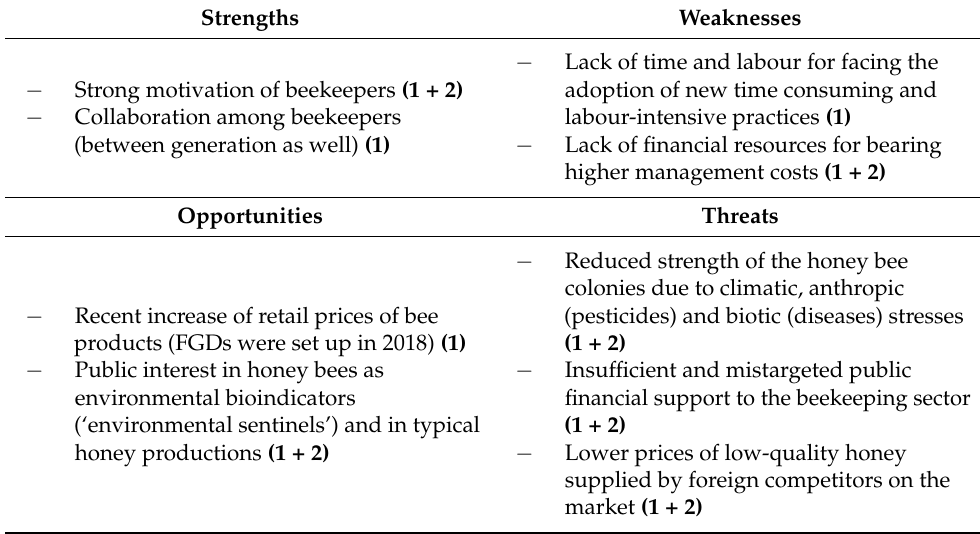
Table 1. SWOT matrix of the beekeeping sector in the surveyed areas. Strengths